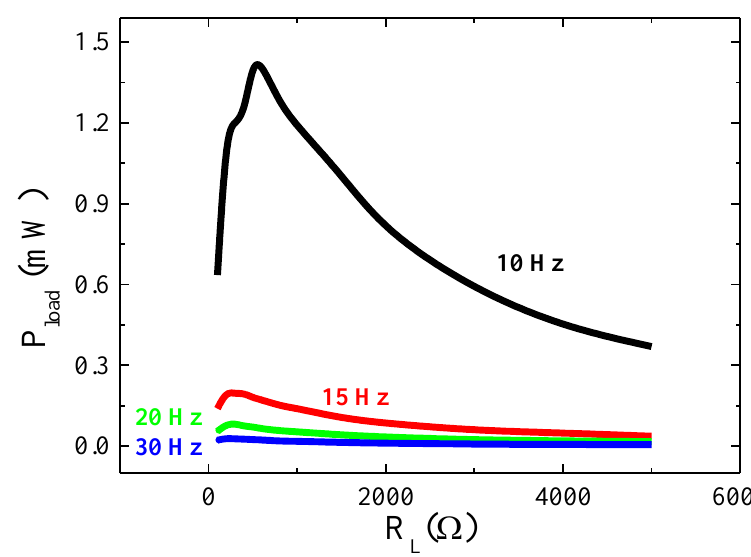
Figure 7. Electrical power, P load , versus the resistive load, R L for an acceleration of a = 0.5 g.